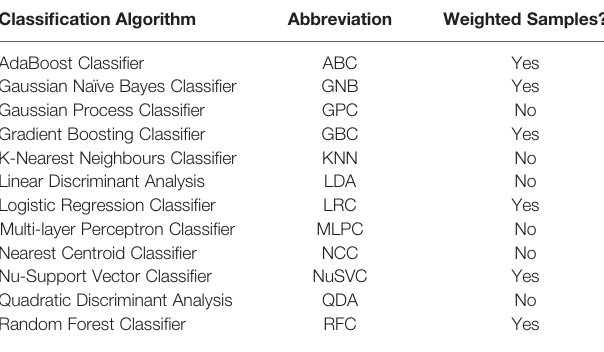
TABLE 2 | List of compared classi fi cation algorithms, their utilized abbreviation, and compatability with using weighted samples when training the individual model. Classi fi cation